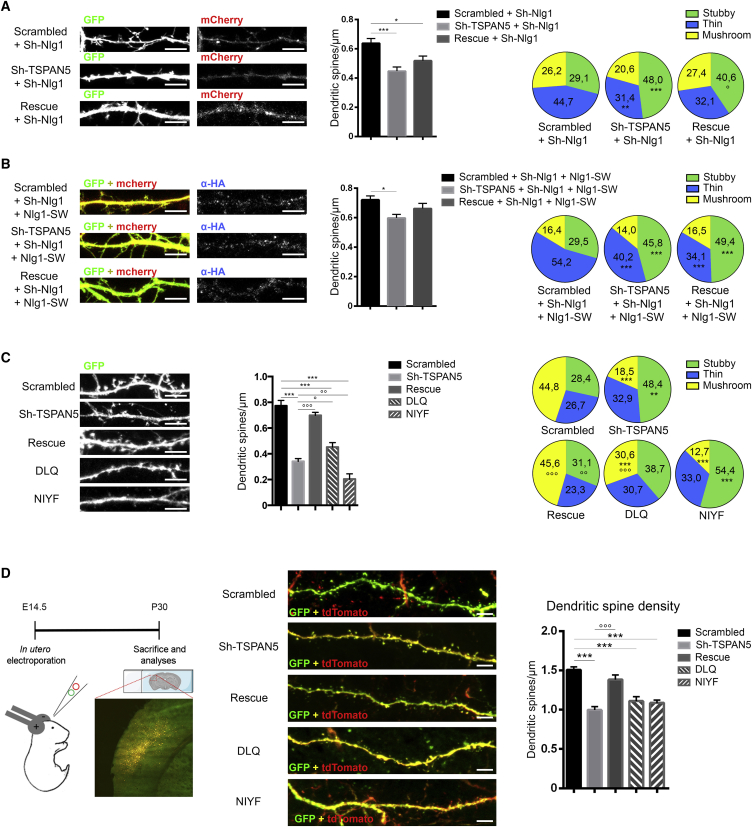
TSPAN5-NLG1 Interaction Is Crucial for Dendritic Spine Maturation(A) Confocal images of DIV 18 rat hippocampal cultured neurons transfected at DIV 5 with a GFP co-expressing Sh-Nlg1 and either scrambled, Sh-TSPAN5, or rescue constructs all co-expressing mCherry. Scale bar, 5 μm. Quantification of dendritic spine density (dendritic spine/micrometer). Pie charts show dendritic spine morphology as percentages of spines in three categories: stubby, thin, and mushroom. Scrambled, n = 17 neurons; Sh-TSPAN5, n = 19 neurons; rescue, n = 15 neurons.(B) Confocal images of DIV 18 rat hippocampal cultured neurons transfected at DIV 5 with a GFP co-expressing Sh-Nlg1, HA-tagged NLG1 SWAP mutant (Nlg1-SW), and scrambled, Sh-TSPAN5, or rescue constructs all co-expressing mCherry and immunolabeled for HA (blue). Scale bar, 5 μm. Quantification of dendritic spine density (dendritic spine/micrometer). Pie charts display dendritic spine morphology as percentages of spines in three categories: stubby, thin, and mushroom. Scrambled, n = 19 neurons; Sh-TSPAN5, n = 17 neurons; rescue, n = 17 neurons.(C) Confocal images of DIV 18 rat hippocampal cultured neurons transfected at DIV 5 with scrambled, Sh-TSPAN5, rescue, DLQ, or NIYF constructs all co-expressing GFP. Scale bar, 5 μm. Quantification of dendritic spine density (dendritic spine/micrometer). Pie charts show dendritic spine morphology as percentages of spines in three categories: stubby, thin, and mushroom. Scrambled, n = 16 neurons; Sh-TSPAN5, n = 14 neurons; rescue, n = 16 neurons; DLQ, n = 16 neurons; NIYF, n = 16 neurons.(D) In utero electroporation experiment. Left panel: experiment timeline schematic. E13.5 mice embryos were electroporated with pCAG-tdTomato and scrambled, Sh-TSPAN5, rescue, DLQ, or NIYF constructs all co-expressing GFP and perfused at P30 for imaging. Central panel: confocal images of secondary dendrites of cortical pyramidal neurons. Scale bar, 5 μm. Right panel: quantification of the density of dendritic spines (dendritic spines/micrometer). Scrambled, n = 44 dendrites; Sh-TSPAN5, n = 45 dendrites; rescue, n = 37 dendrites; DLQ, n = 45 dendrites; NIYF, n = 40 dendrites from three animals per condition.Exact values are shown in Table S1. Graphs represent mean ± SEM. ∗p < 0.05, ∗∗p < 0.01, and ∗∗∗p < 0.001 versus Scrambled; °p < 0.05, °p < 0.01, and °p < 0.001 versus Sh-TSPAN5.